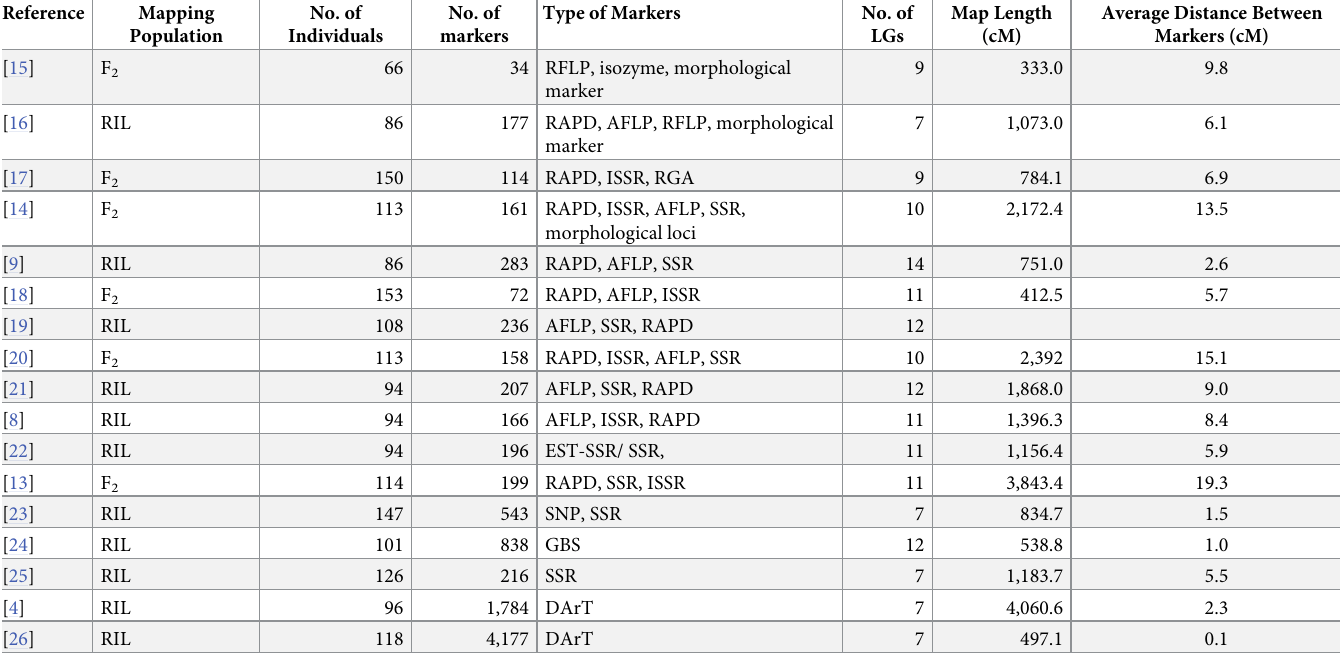
Table 1. Information of previous lentil linkage